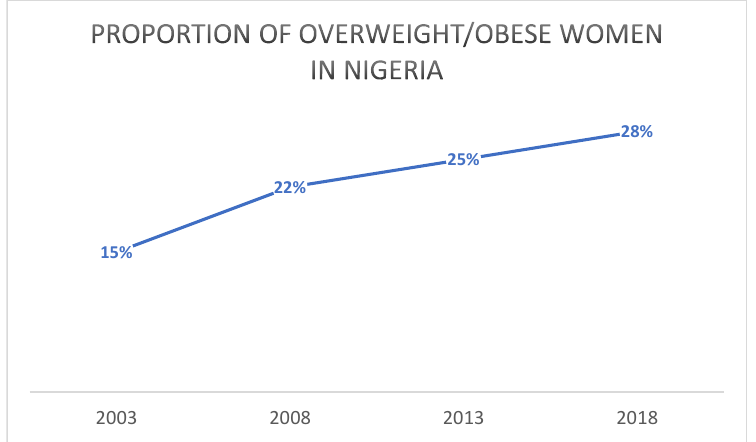
Figure 1. Proportion of overweight/obese Nigerian women between 2003 and 2018. Source: DHS 2018.